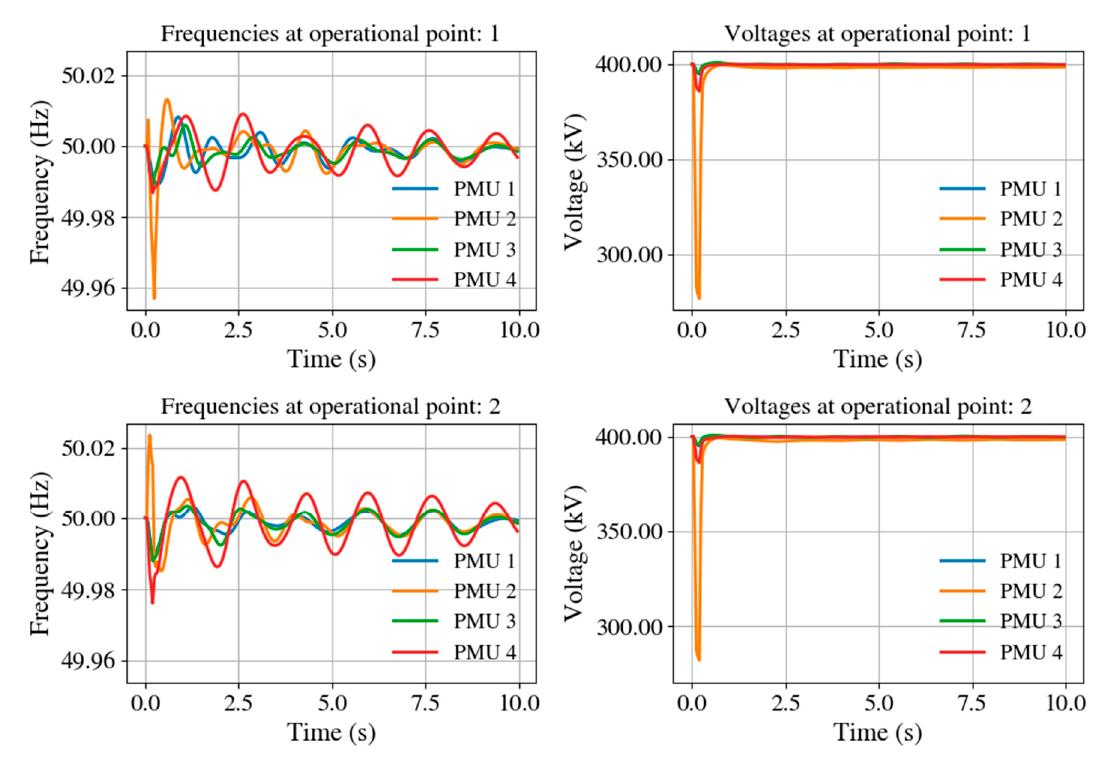
Figure 11. Exemplary simulations of four PMUs for a short circuit at line L19 (90% line length) including frequencies ( top and bottom left ) and voltage magnitudes ( top and bottom right ) for two operational points.